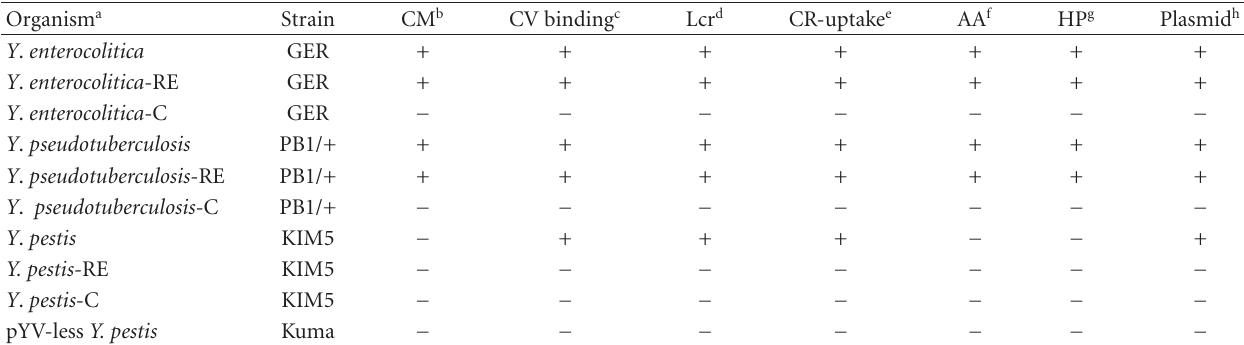
a Cells recovered from red pinpoint colonies and subcultured in BHI broth at 28 ◦ C are designated as RE. The pYV-negative strains of Y . enterocolitica , Y . pseudotuberculosis , and Y . pestis are designated as C (cured). b CM:colonymorphology.Oncalcium-adequateBHA(1500 µ MCa 2+ ),andTSA(1400 µ MCa 2+ )theP + cellsappearedassmallcolonies(1.13mmindiameter) as compared to larger P − colonies (2.4mm in diameter). c CV binding: crystal violet binding. The P + cells appeared as small dark-violet colonies, and the P − cells showed large white colonies on calcium-adequate BHA (1500 µ M Ca 2+ ) and TSA (1400 µ M Ca 2+ ), low-calcium CR-BHO (238 µ M Ca 2+ ), CR-TSO (311 µ M Ca 2+ ), and calcium-deficient CR-MOX. d Lcr: low calcium response/calcium-dependent growth. P + cells appeared as pinpoint colonies (0.36 in diameter), and P − cells appeared large colonies (1.37 in diameter) on low-calcium CR-BHO (238 µ M Ca 2+ ), CR-TSO (311 µ M Ca 2+ ), and calcium-deficient CR-MOX. e CR-Uptake: Congo red-uptake. The P + cells appeared as red pinpoint colonies (0.36 in diameter), and the P − cells appeared large white or light orange colonies (1.13mm in diameter) on calcium-deficient CR-MOX. f AA: autoagglutination. The P + cells agglutinated. The P − cells remained dispersed.